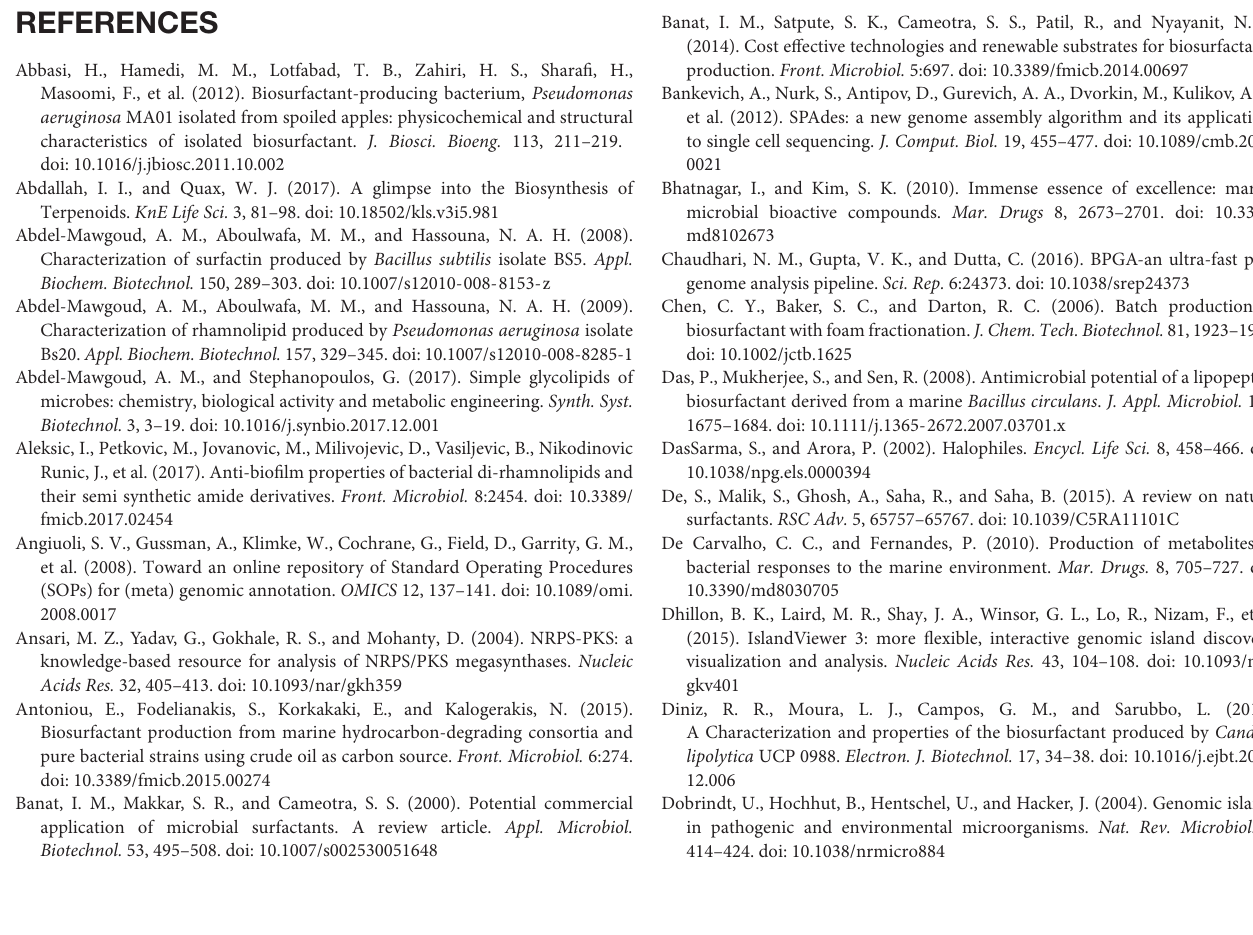
FIGURE S1 | KEGG distribution in core, accessory and unique genomes. FIGURE S2 | Core genome based phylogeny of P. maritimus strains. FIGURE S3 | Glycolipid biosynthesis pathway driven from KEGG annotations to P. maritimus SAMP genome. FIGURE S4 | 13 C NMR spectrum of biosurfactant from P. maritimus SAMP. TABLE S1 | Stability studies of Planococcus derived biosurfactant with different pH, temperature and salt